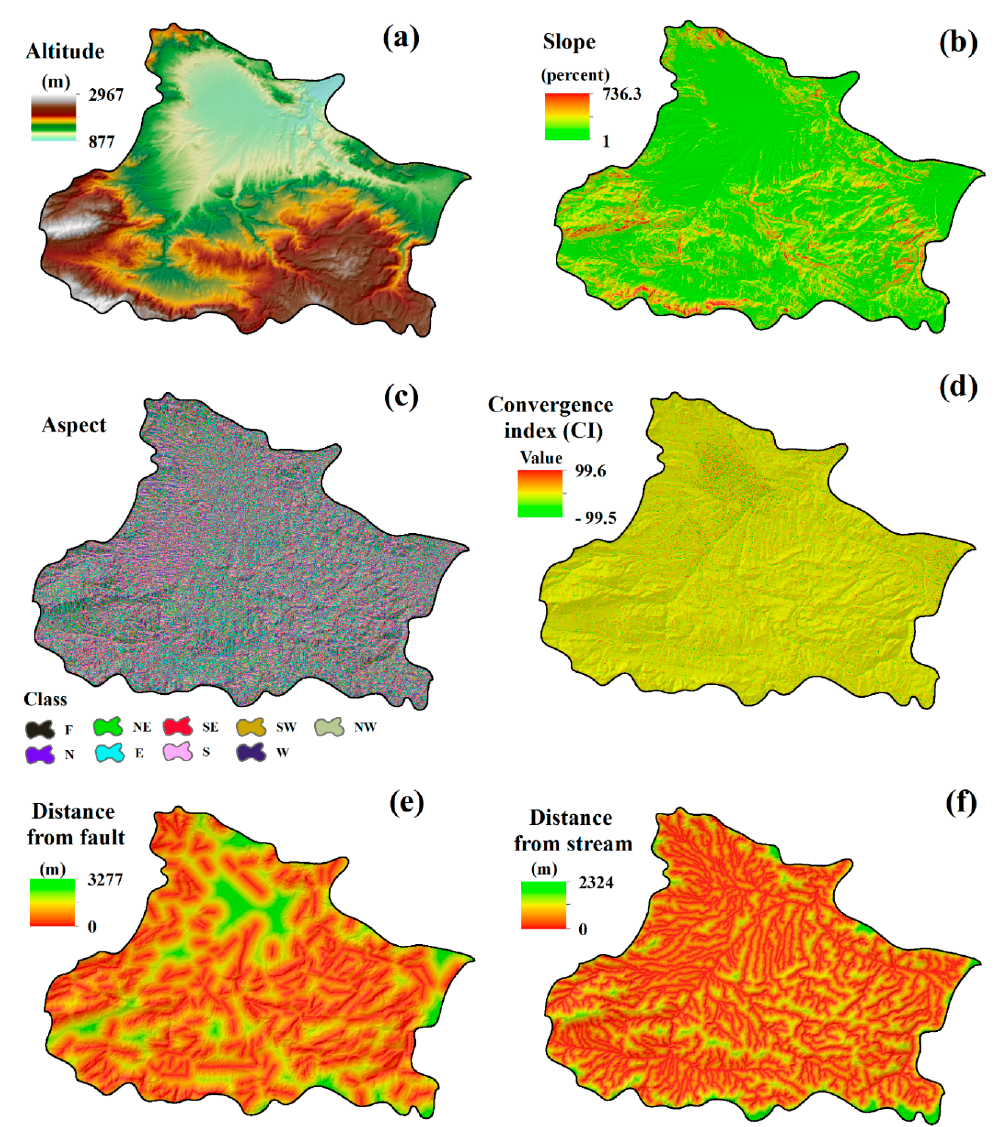
Figure 7. Groundwater-affecting factors (GAFs) in the study area: ( a ) altitude, ( b ) slope, ( c ) aspect, ( d ) convergence index, ( e ) distance from fault, and ( f ) distance from stream (for a detailed description of lithological classes, see Table 3).